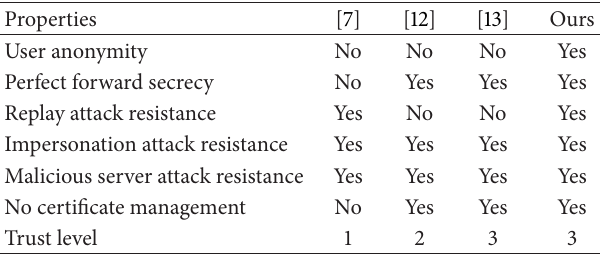
Table 1: Functionality comparisons. Table 2: Cryptographic operation time.